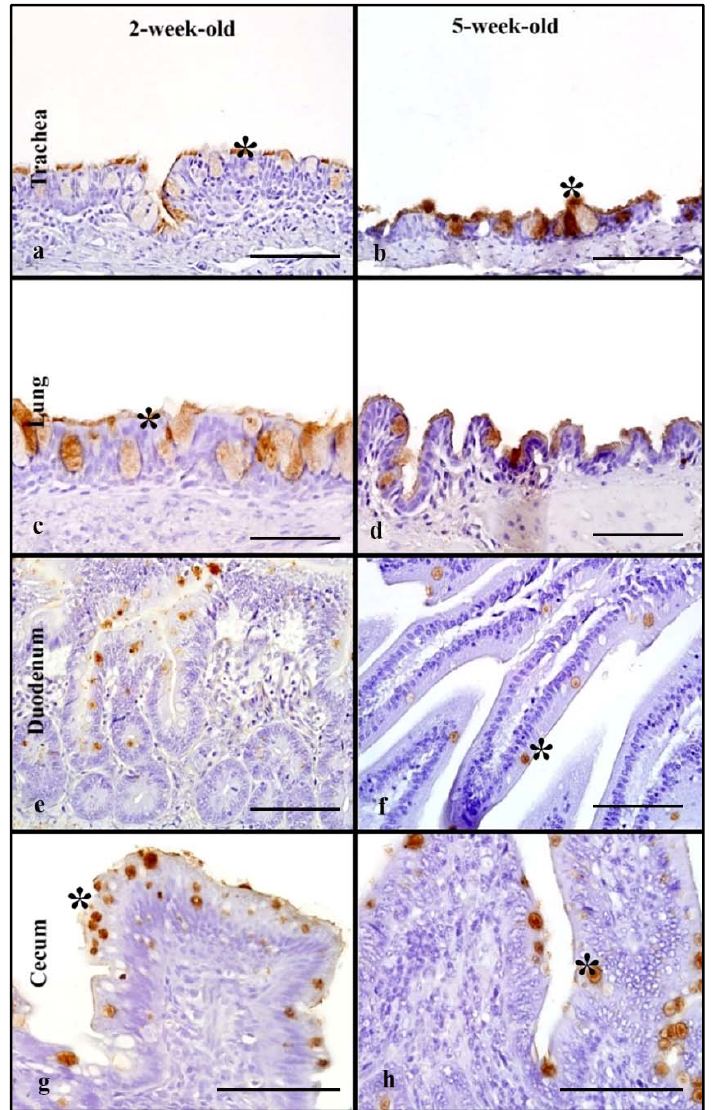
Figure 1. HPAIV H5 rHA binding in Mallard ducks of different age groups, visible as dark brown staining using 3, 3-diaminobenzimidine (DAB) HRP via protein histochemistry, denoted by asterisk (*). In the trachea ( a , b ), strong levels of rHA binding is seen in 2-week-old and 5-week-old Mallards. Note higher levels of HA binding in the lung of the 2-week-old ( c ) compared to the 5-week-old. In the upper intestine, slightly stronger levels of rHA binding is seen in the 2-week-old ( e ) compared to the 5-week-old. Note similar, very strong levels of rHA binding in the cecum of both 2-week-old and 5-week-old birds. Scale bar is 50 µm.